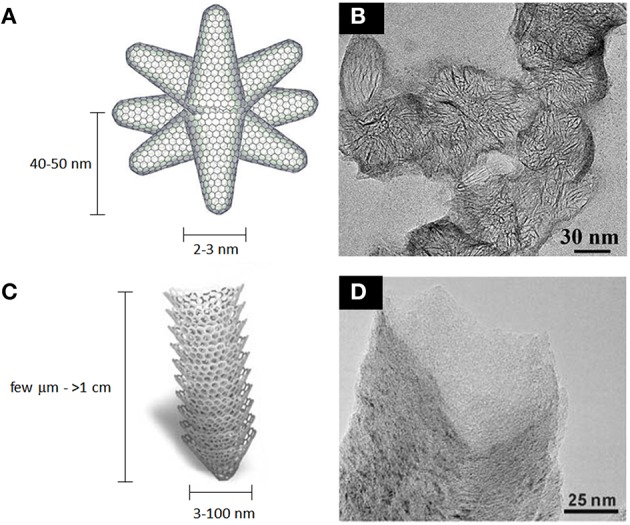
Schematic representation of SWCNHs (A) and stacked-cup CNFs (C). (B) TEM micrograph of ~80 nm SWCNHs peapods. (D) TEM micrograph of stacked-cup CNFs. (A,B) adapted from Voiry et al. (2015) with permission from The Royal Society of Chemistry. (C,D) adapted from Sato et al. (2005) with permission from The Royal Society of Chemistry.